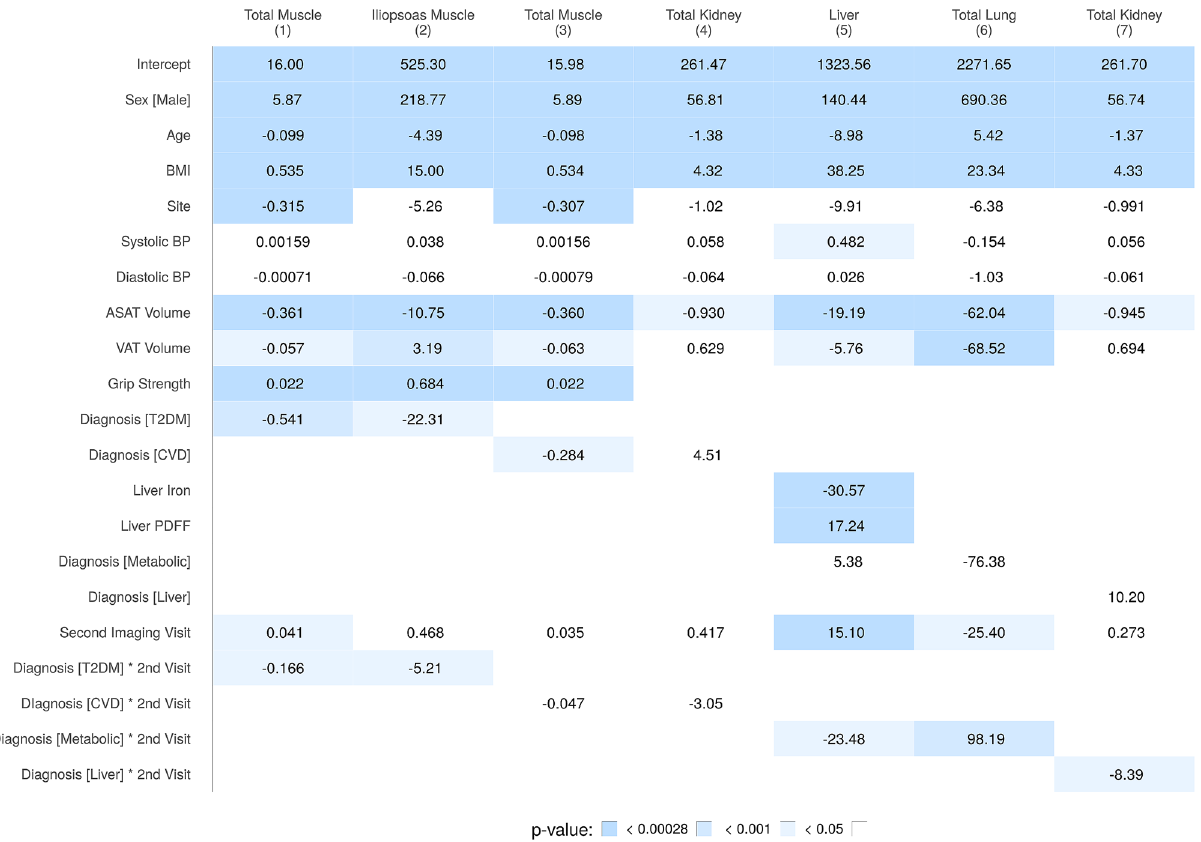
Figure 2. Summary of regression coefficients for the mixed-effects models in Table 2. All dependent variables are volumes measured in milliliters (ml), execept for total muscle (Models 1 and 3), ASAT and VAT which are in liters (l). ASAT: abdominal subcutaneous adipsose tissue; BMI: body mass index; BP: blood pressure; CVD: cardiovascular disease; PDFF: proton density fat fraction; T2DM: type-2 diabetes mellitus; VAT: visceral adipose